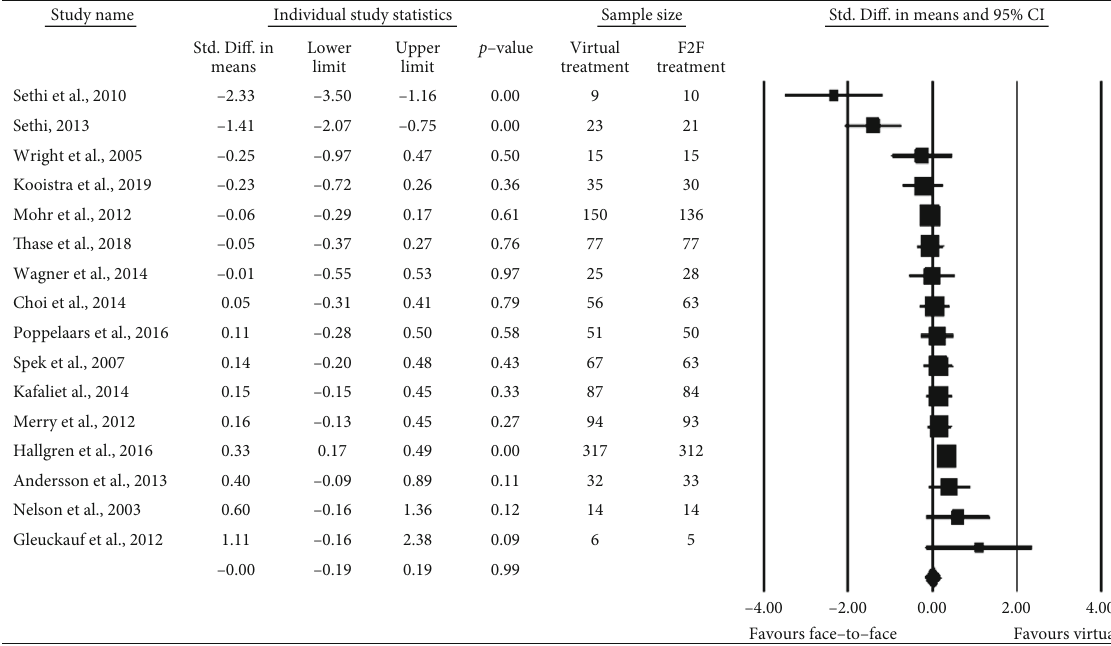
Figure 2: Critical posttest comparisons of virtual and face-to-face CBT.